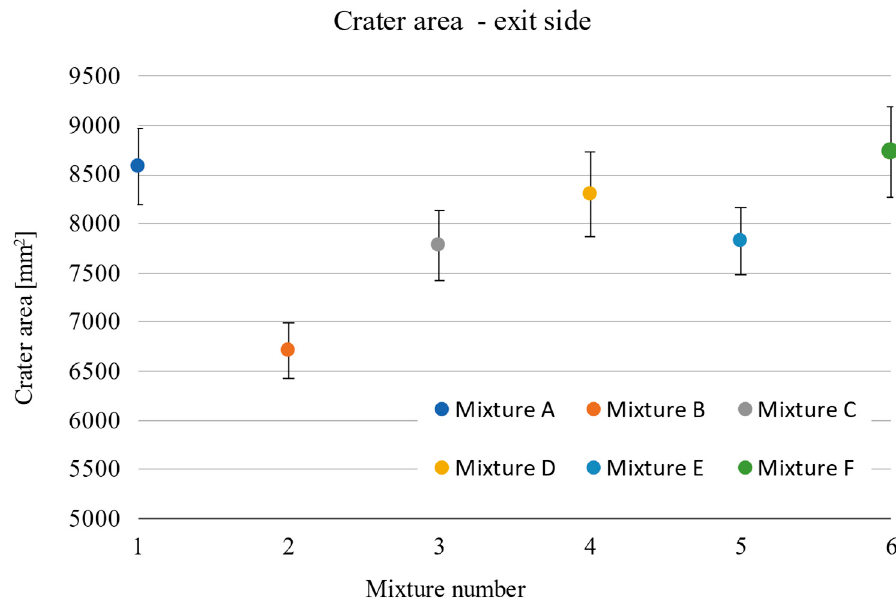
Figure 12. Area of exit crater by individual mixtures.